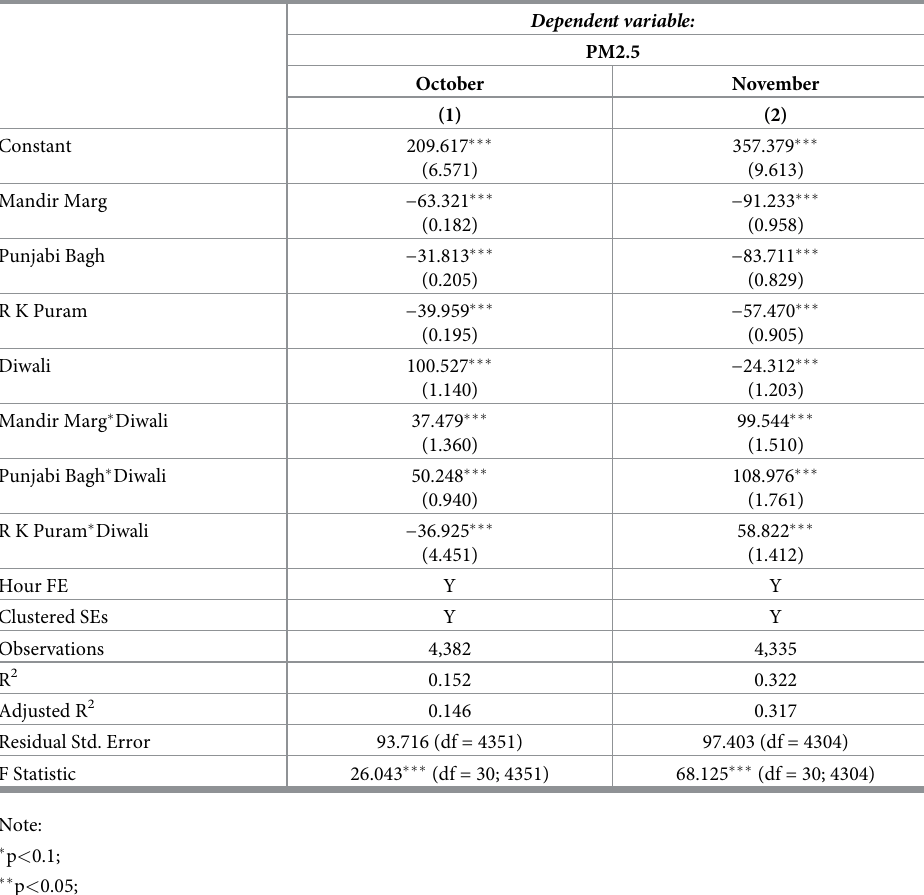
Table 2. Regression results: Part